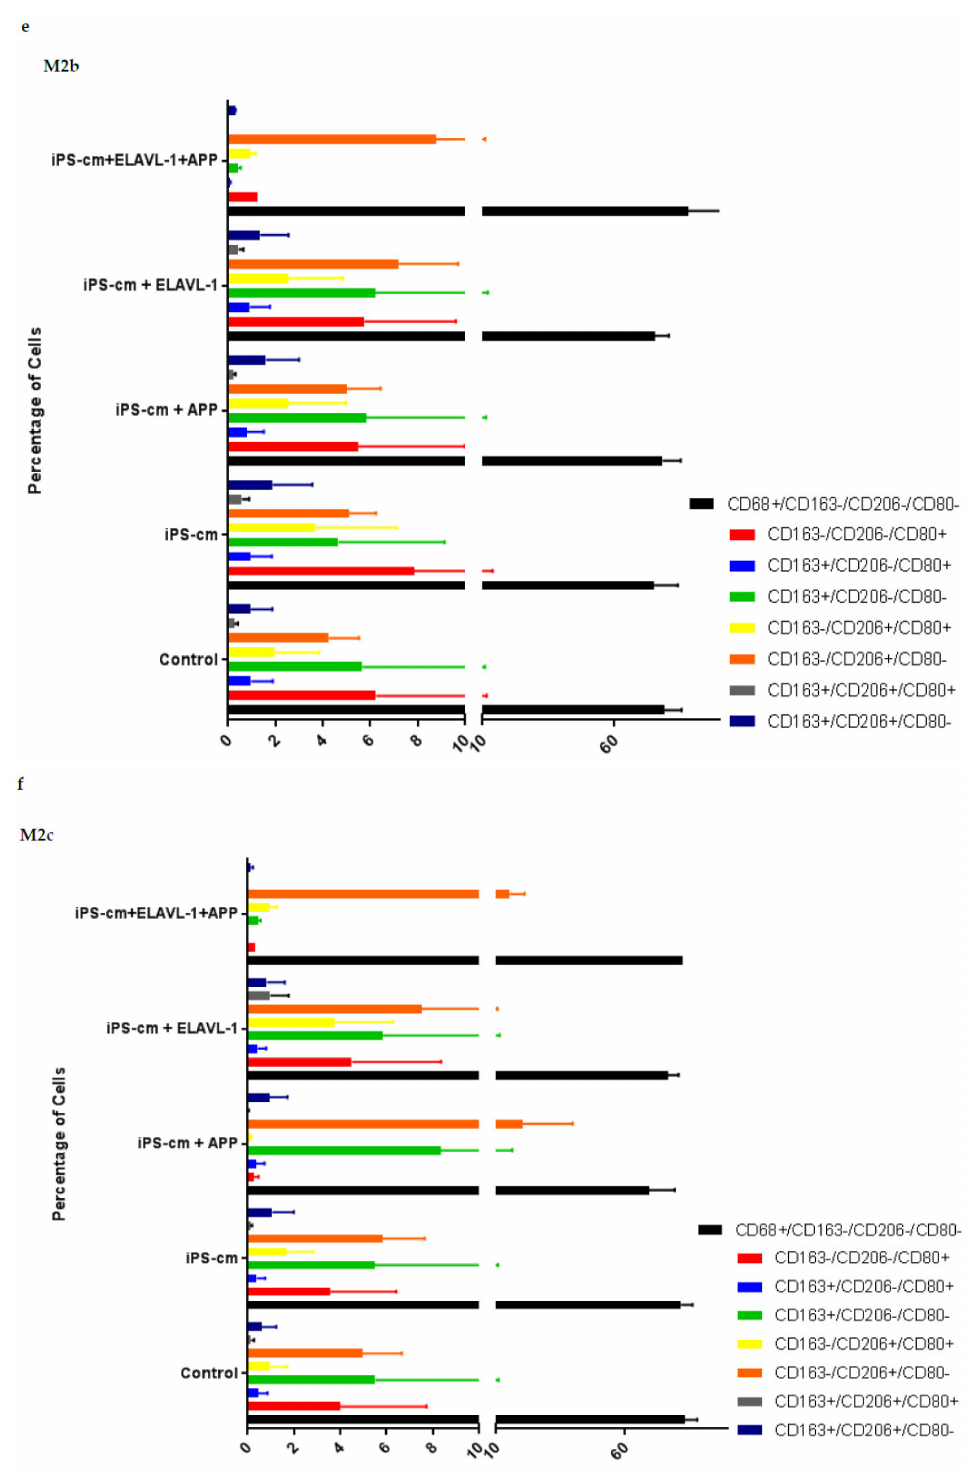
Figure 3. Depletion of APP altered surface expression of M0 ( a ) and M2c ( f ). Combined depletion of APP and ELAVL-1 in iPSC-CM increased CD206+ cells in M1 ( b ), M2 ( c ) and M2a ( d ) subtype. Depletion of APP in the iPSC-CM reduced CD163+/CD206+/CD80+ populations in M0 subtype compared to control. APP depletion increased CD163-/CD206+/CD80- populations in M2c subtype iPSC-CM treated macrophages ( p < 0.05) and compared to control media ( p < 0.05). ( n = 4; Mean ± SEM). Finally, depleting both APP and ELAVL-1 in iPSC-CM led to increased expression of CD206 in M1, M2, and M2a subtypes. In M2c subtype, the CD206+ population was also increased, but only compared to control cells. In M2a subtype ( e ), an additional subpopulation of (CD163-/CD206+/CD80+) was increased. ( n = 4; Mean ± SEM). Values are represented in Supplementary Materials Table S1. Flow cytometry histograms are represented as Supplementary Figures S1 and